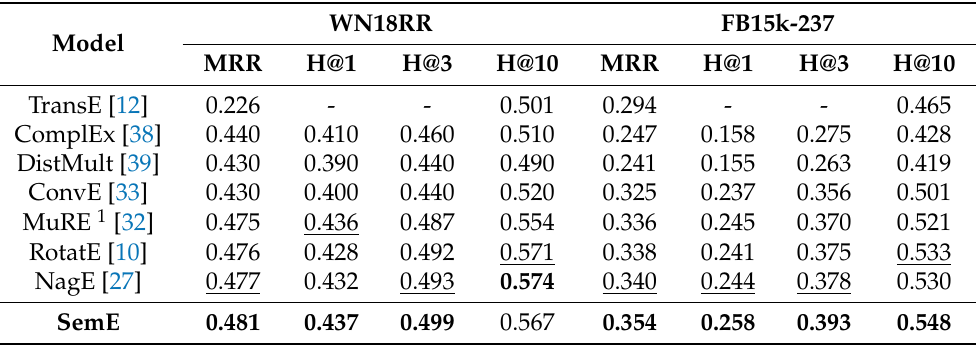
Table 2. Experiment results on WN18RR and FB15k-237 datasets (best scores are marked as bold while the second best are underlined). A standard SemE model is applied for FB15k-237, while a low-dim alternative SemE- δ s is used for